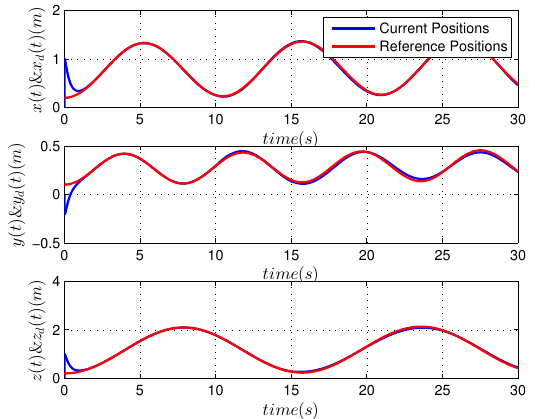
Figure 3. Actuator Anomalies for Attitude Channel.